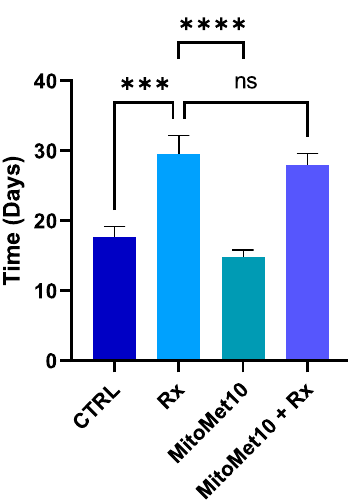
Figure 7. Effect of daily treatment with mito-metformin10 (2 mg/kg) on PC-3 tumor growth delay (in days) after irradiation 6 Gy dose delivered at time of maximal tumor reoxygenation. Data are shown as means ± SEM of tumor growth delay to achieve a 1200 mm 3 tumor volume. (***) p < 0.001, (****) p < 0.0001, (ns) non-significant, Two-way ANOVA N = 9/group.